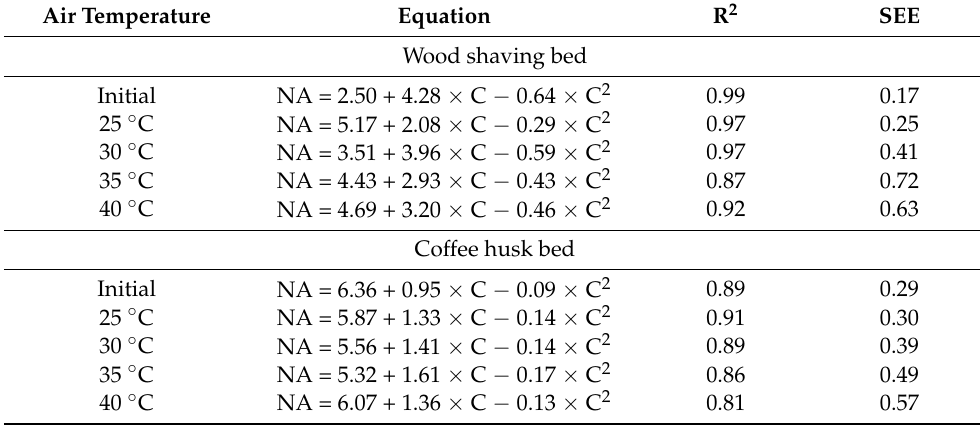
Table 4. Adjusted equations of the ammoniacal nitrogen behavior of the beds according to their cycle of use.